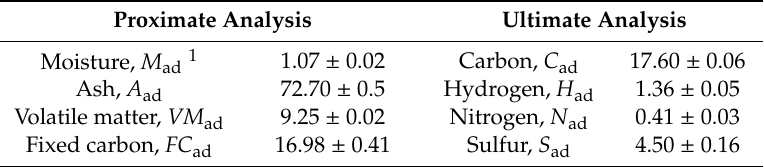
Table 2. Proximate and ultimate analysis of coal gangue (wt%, mean ± SD, n = 3).